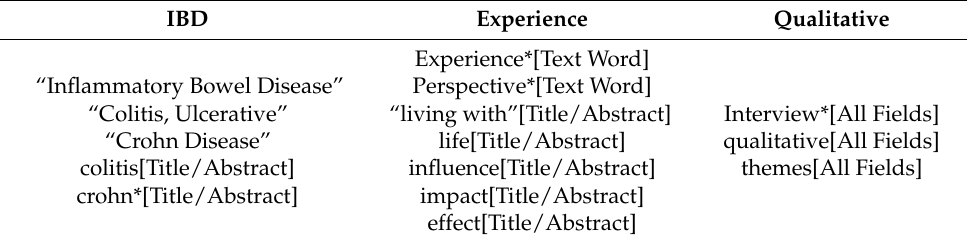
Table 1. Electronic database search